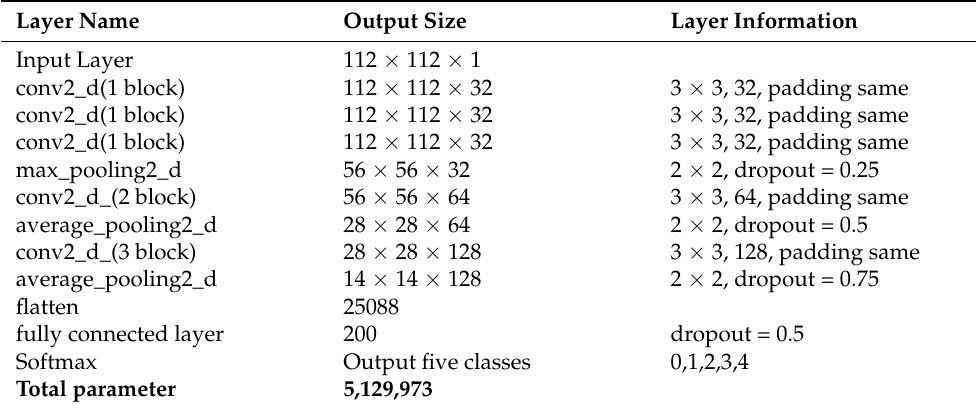
Table 2. The configuration detail of the proposed model with their output